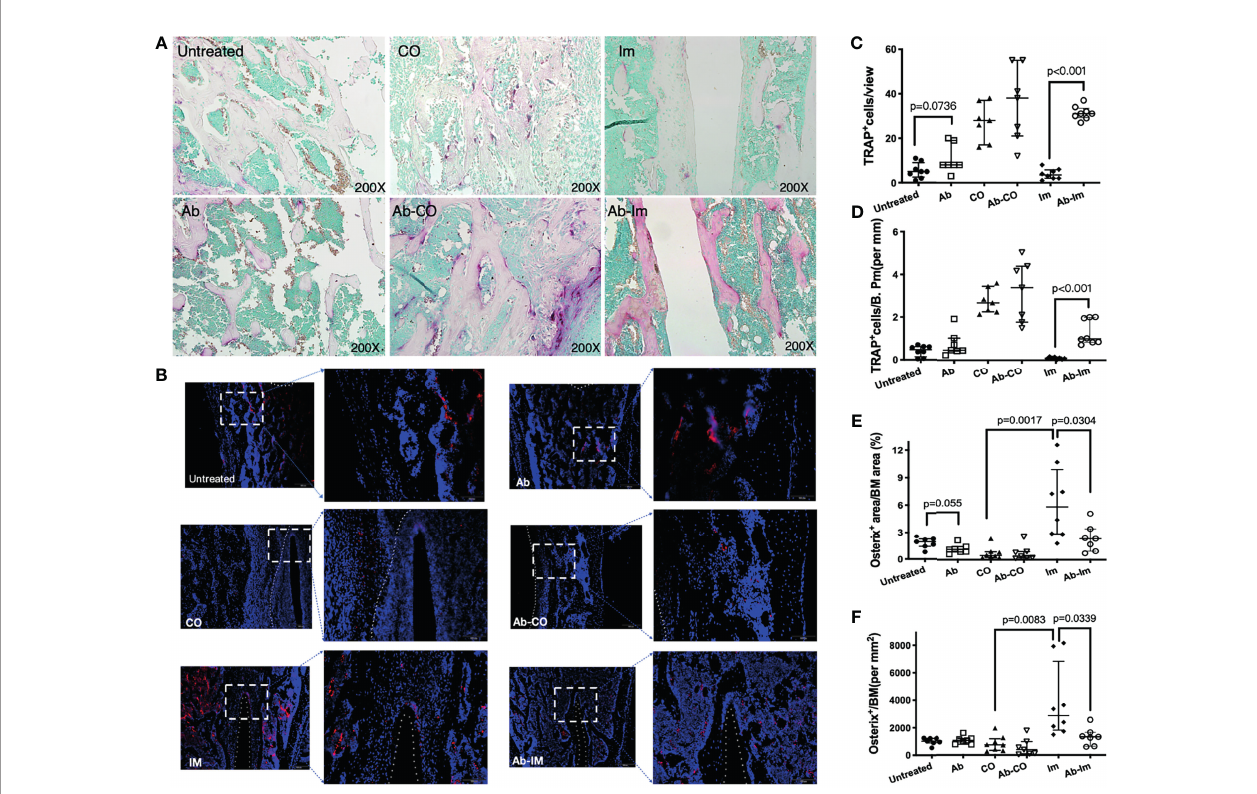
FIGURE 4 | Antibiotic-induced gut microbiota dysregulation enhanced osteoclast activity and inhibited osteoblast function. Distal femur specimens were harvested and stained using TRAP ( A , 200× magni fi cation) and osterix antibody ( B , 200× magni fi cation) at 4 weeks postsurgery. Osteoclasts expressing TRAP are shown in purplish red, demonstrating osteoclastogenesis activity. Osterix expression in the femoral specimens was highlighted by an immuno fl uorescence assay and demonstrated osteoblastogenic activity. Nuclei are stained with DAPI. (C) TRAP + cell counts in view. (D) TRAP + cell counts in trabecular bone. (E) Osterix + cell counts in bone marrow cavity. (F) The area percentage of osterix-positive signals. Cell counts and area percentages are shown as the median and interquartile range. All data are analyzed by unpaired t -test between untreated and Ab, Ab-CO and CO, or between Ab-Im and Im